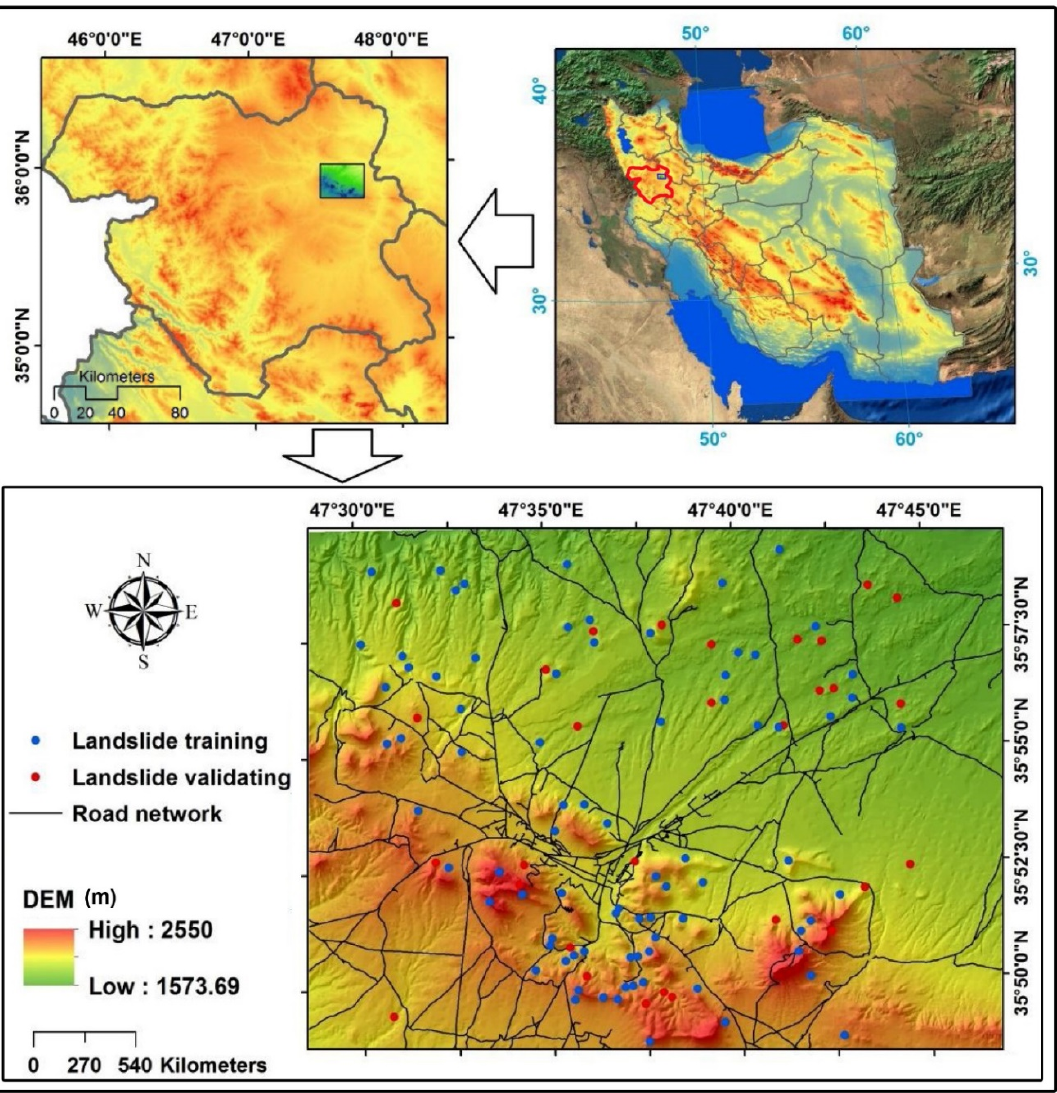
Figure 1. Location of shallow landslides in the study area. The blue circles denote landslides for training the algorithms, and the red circles denote landslides for validating the algorithms.